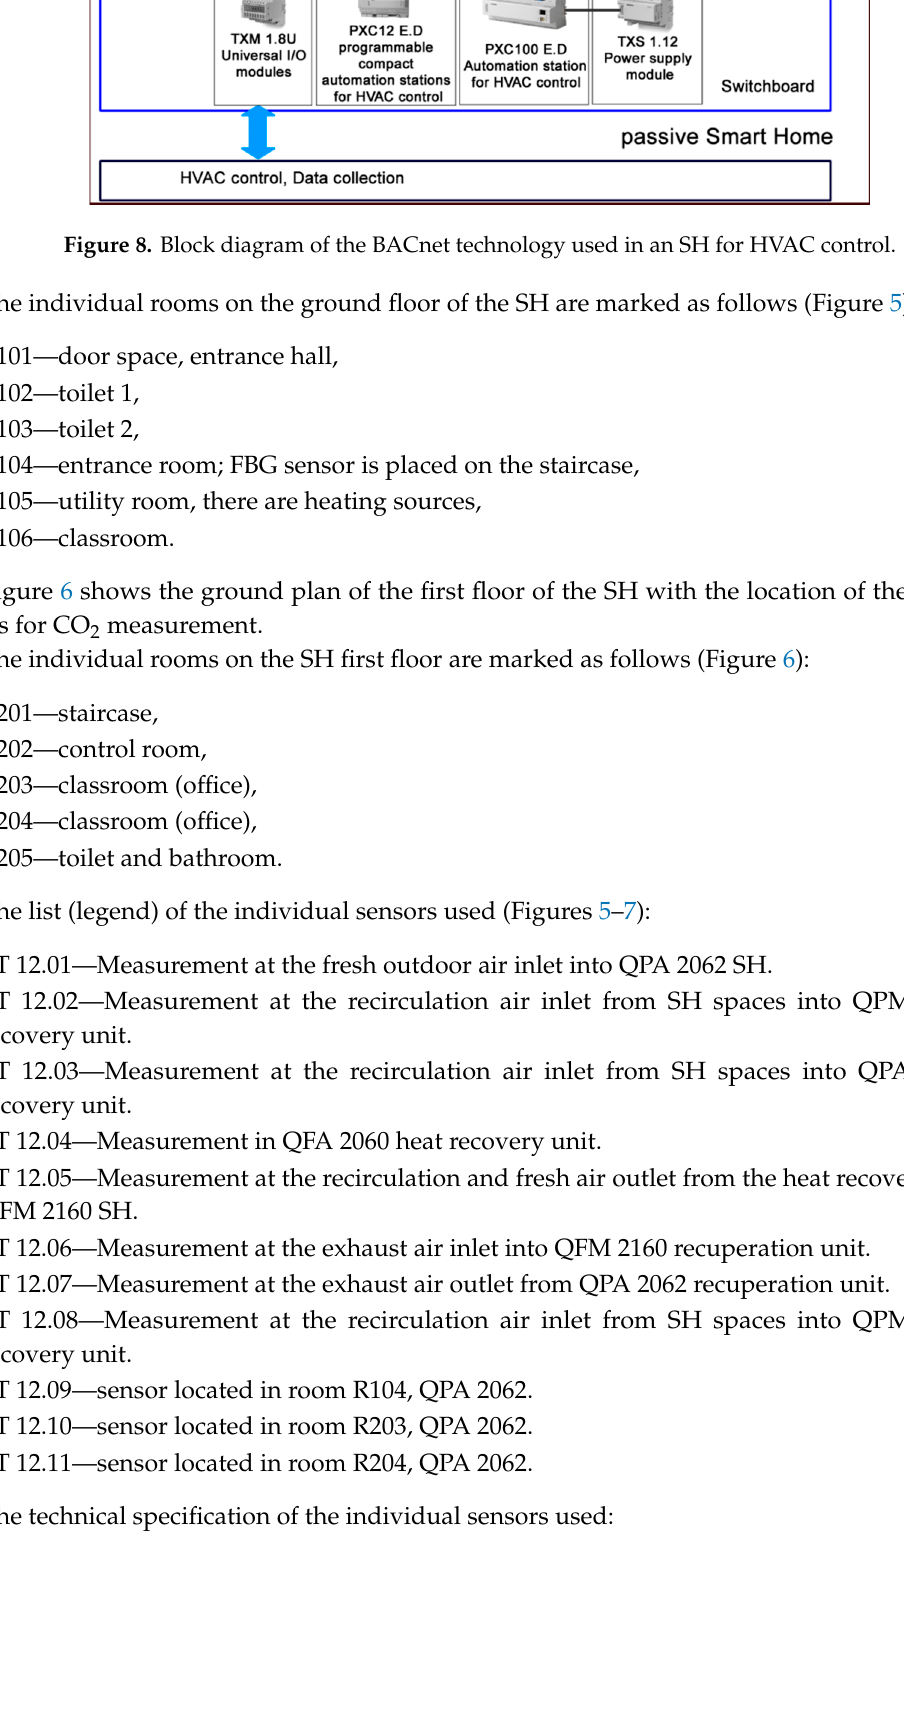
Figure 7. The ventilation distribution technology with the location of the individual sensors for CO 2 measurement in an SH.